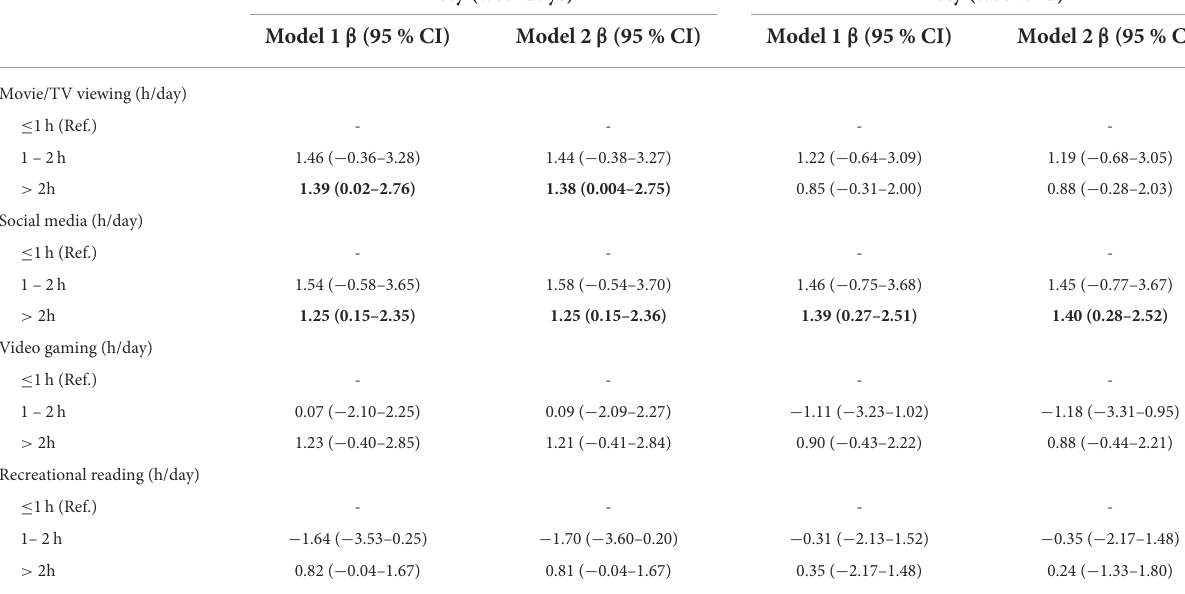
TABLE 3 Associations of screen-based sedentary behaviors during weekdays and weekend with anxiety.